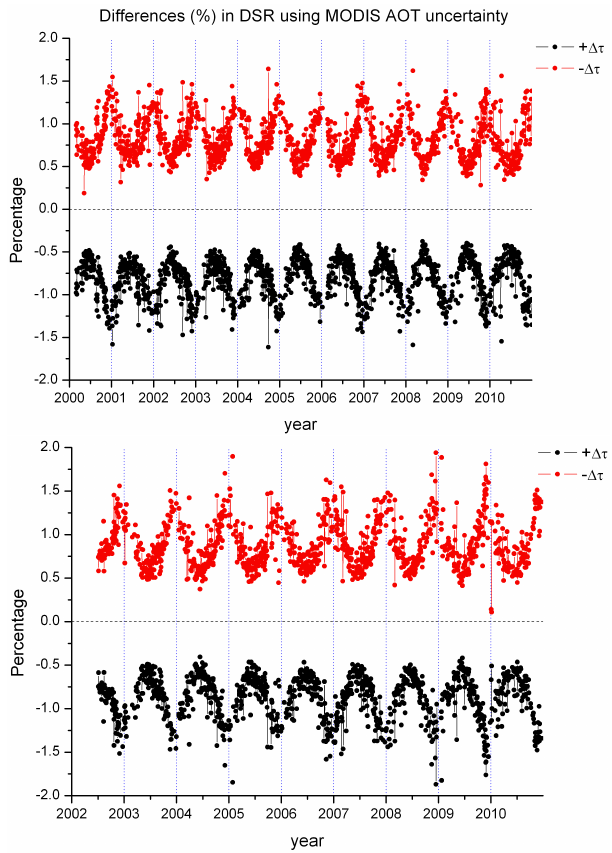
Fig. 6. Timeseries of the differences in model instantaneous DSR (Wm − 2 ) , using Terra (a) and Aqua (b) MODIS AOT data and the error limits of the AOT retrieval algorithm ( τ ± 1τ) , above the HCMR station, for the years